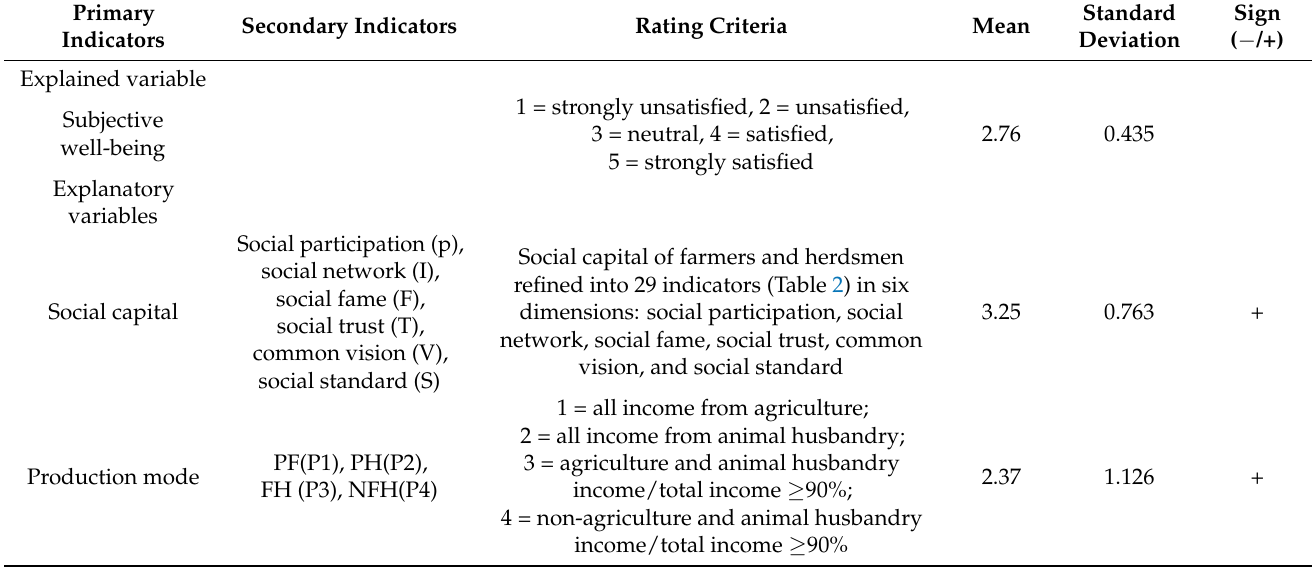
Table 3. Variable definitions and calculation